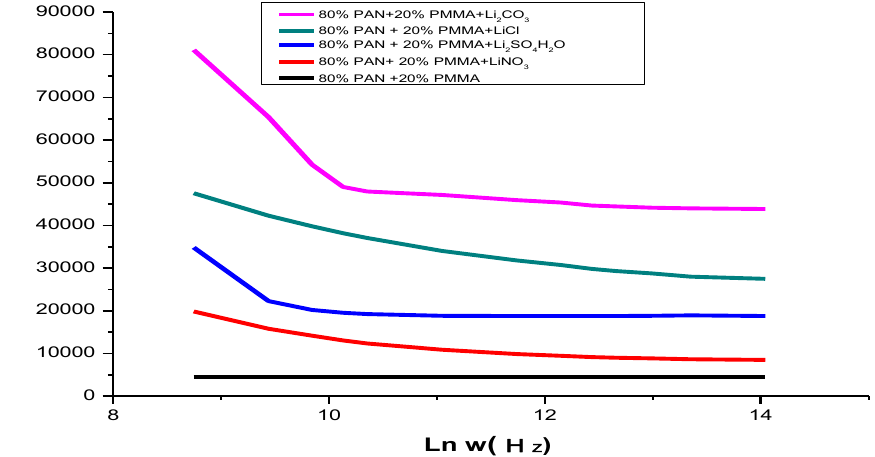
Figure 2a: The real dielectric constant as function of ln (ω) of undoped (82%PAN +20%PMMA) and doped with 20% (LiNO